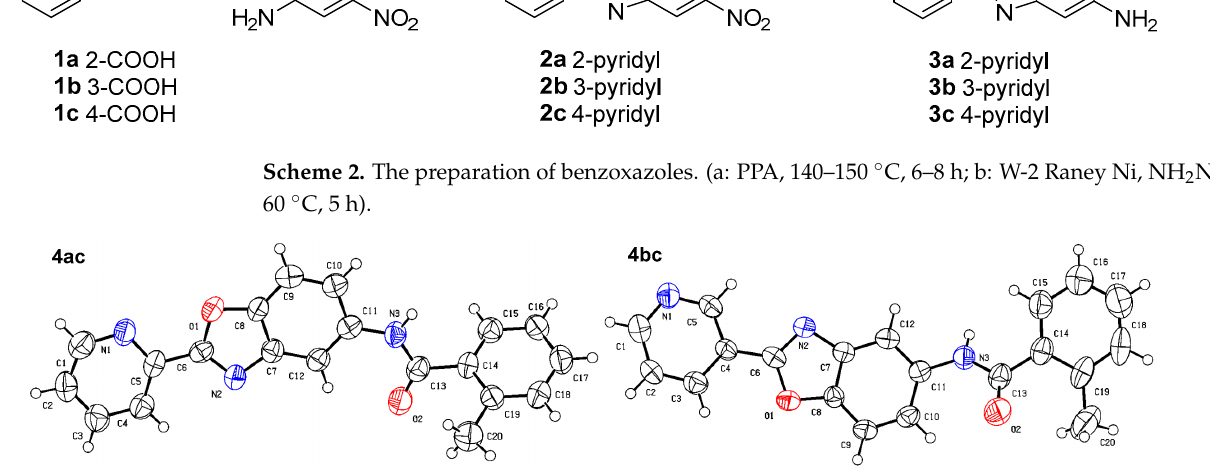
Figure 3. X-ray crystallographic structures of 4ac and 4bc . Table 1. The syntheses of amide derivatives of benzoxazoles a .